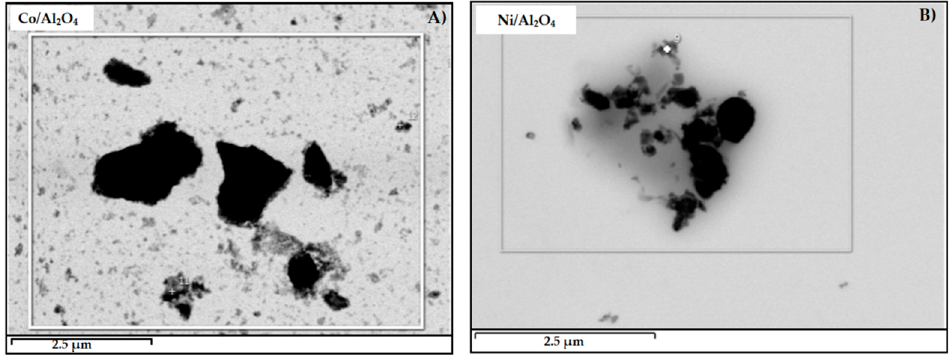
Figure 11. Morphological structure of Co/Al 2 O 4 ( A ) and Ni/Al 2 O 4 ( B ) obtained from TEM.